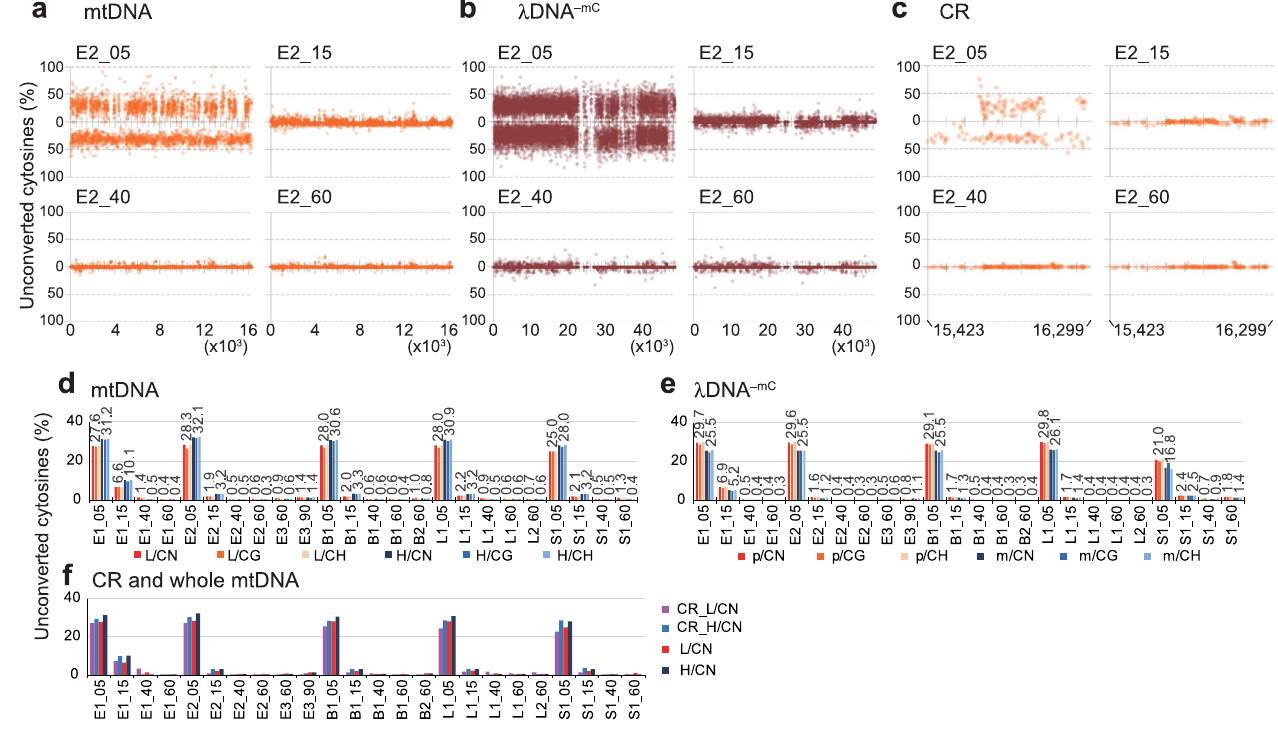
Figure 3. Analysis of methylation status of mtDNA by next-generation bisulfite sequencing. ( a – c ) Cytosine unconversion rates at cytosine sites with coverage of ≥ 10 in whole mtDNA of an ESC mtNA preparation (E2) ( a ), λ DNA − mC mixed as an internal control ( b ) and the control region (CR) of the mtDNA ( c ) are plotted according to nucleotide numbers (X axis) from 1 to 16,299 for mtDNA, from 1 to 48,502 for λ DNA − mC and from15,423 to 16,034 for the CR, and unconversion rates in percentages (Y axis). Nucleotide positions on X axes are shown below graph fields. Plots for L strands of mtDNA and plus strands of λ DNA − mC are shown above X axes with percentages of unconversion increasing upwards, and H strands and minus strands below X axes downwards. Graphs with higher resolution are shown in Supplementary Fig. S3. ( d,e ) Average unconversion rates of cytosines with coverage of ≥ 10 in whole mtDNA and λ DNA − mC . For each sample shown are average unconversion rates of all cytosines in CN (N = A, G, C and T), CG and non-CG sequences in L strands and H strands of whole mtDNA (L/CN, L/CG, L/CH, H/CN, H/CG and H/CH, respectively) ( d ) and in plus strands and minus strands of λ DNA − mC (p/CN, p/CG, p/CH, m/CN, m/CG and m/CH, respectively) ( e ). Percentages of unconverted cytosines in L/CN, H/CN, p/CN and m/CN are shown above the bars. ( f ) Comparisons of average unconversion rates of cytosines with coverage of ≥ 10 in L strands and H strands of the CR of mtDNA and whole mtDNA (CR_L/CN, CR_H/CN, L/CN and H/CN, respectively). Sample names are presented as in Fig.